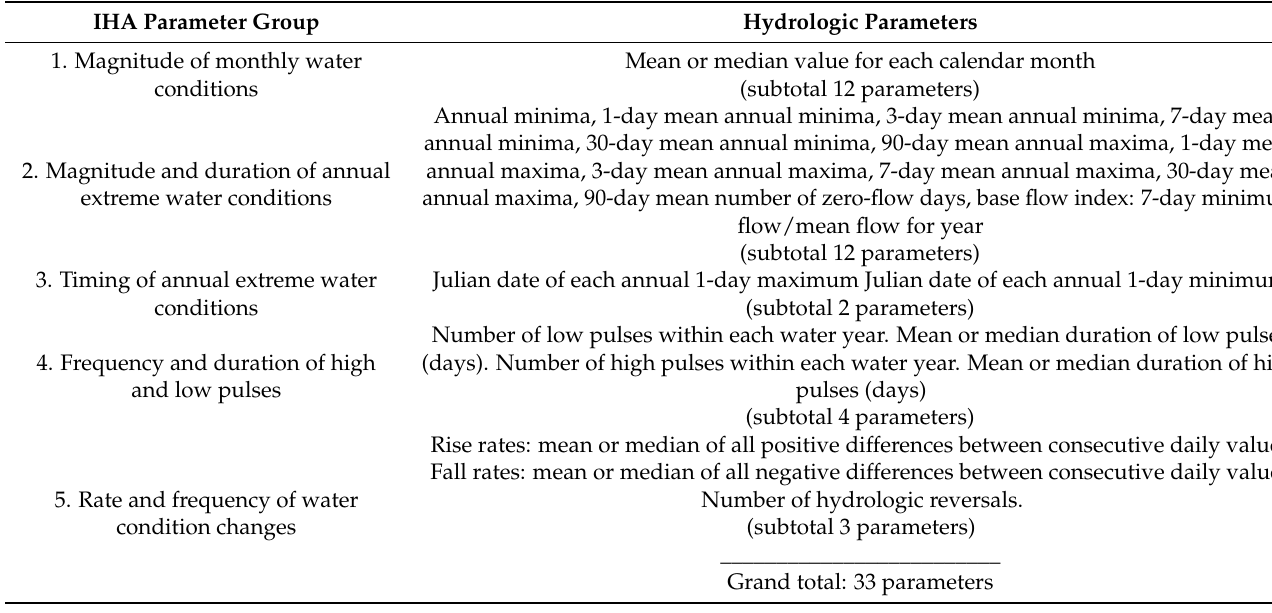
Table A1. Summary of IHA parameters.